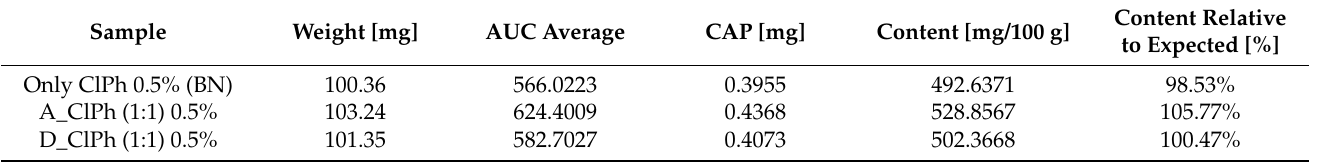
Table 4. Content of the active substance in a 1% carbpol gel as determined by the HPLC